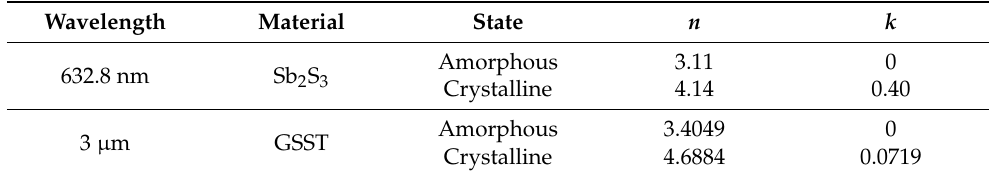
Table A1. The real part n and imaginary part k of the refractive index of Sb 2 S 3 and GSST at the wavelengths used in our